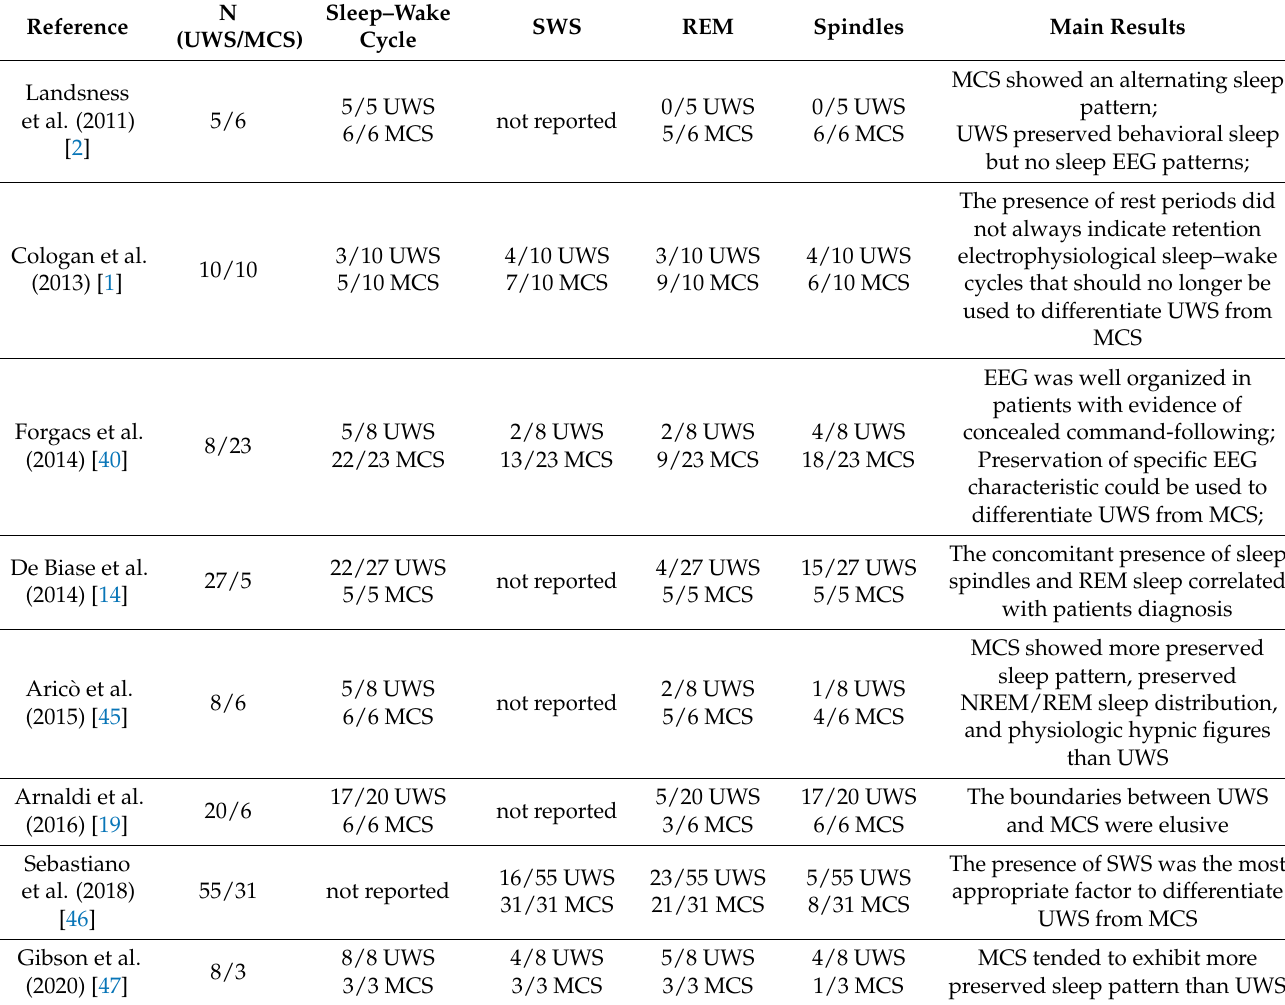
Table 1. Sleep phenomena in UWS and MCS